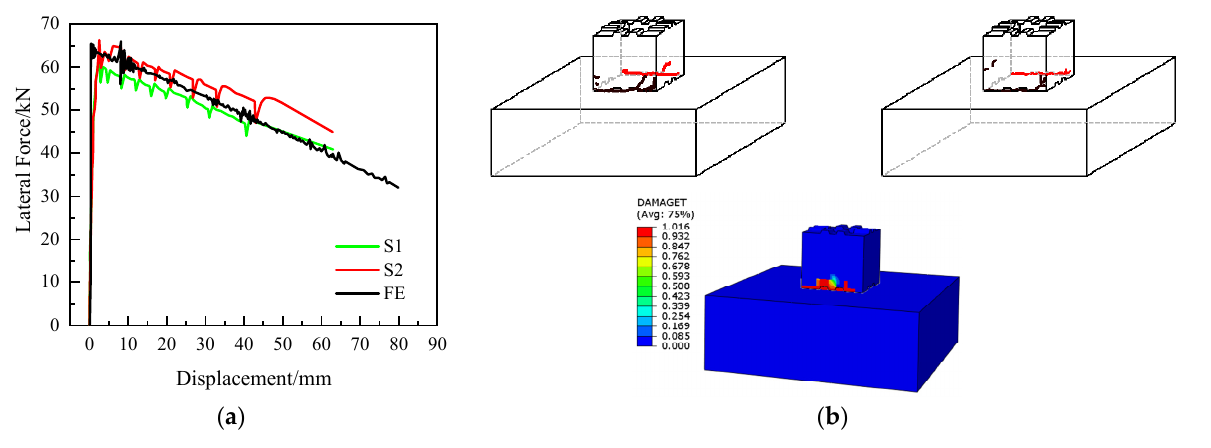
Figure 13. Comparison of the result between test and FEM simulation. ( a ) Load–deflection curve. ( b ) Damage pattern.